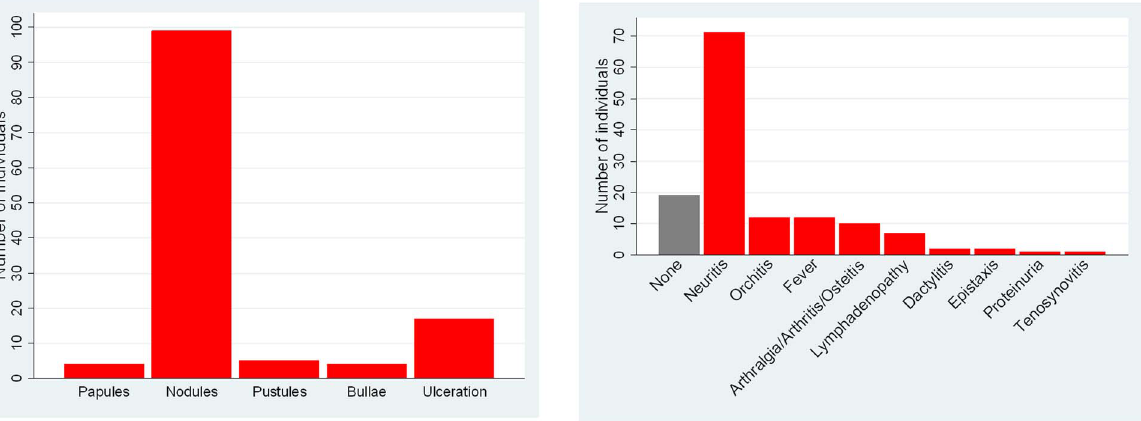
Figure 1. (A) Number of patients with different type of ENL skin lesions. (B) Number of patients with different extra-cutaneous manifestations of